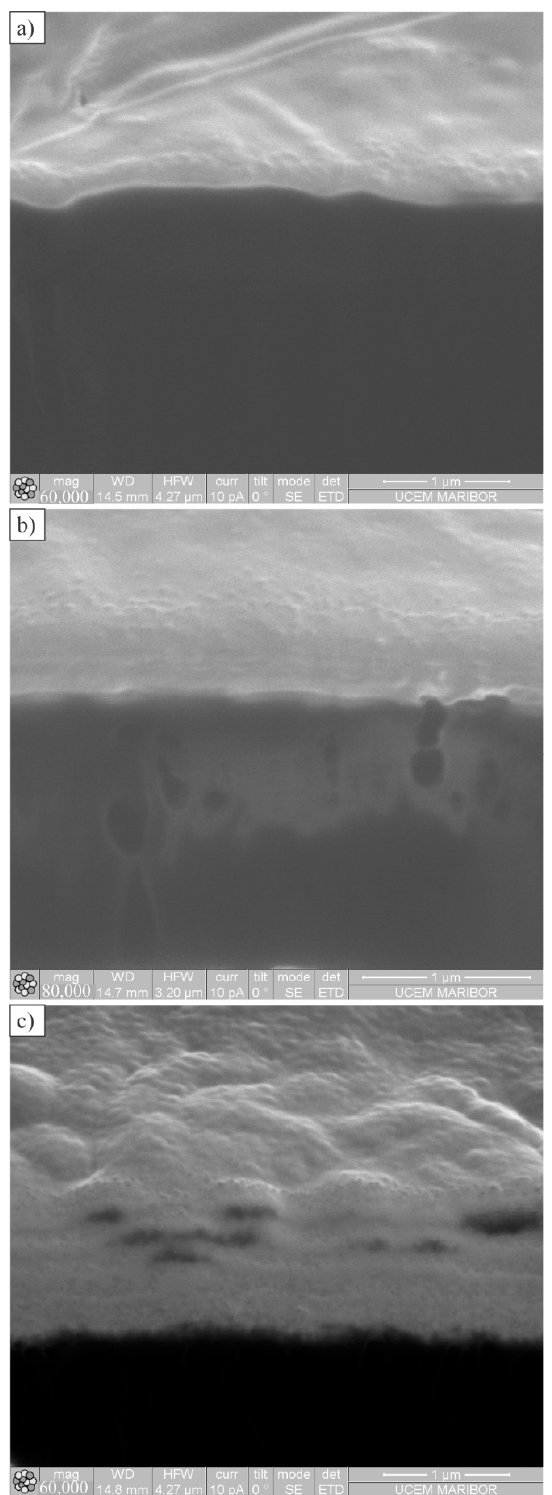
Figure 5. The SEM-FIB cross-sections of coated gear surfaces: ( a ) One coating layer; ( b ) Three coating layers; ( c ) Five coating layers.